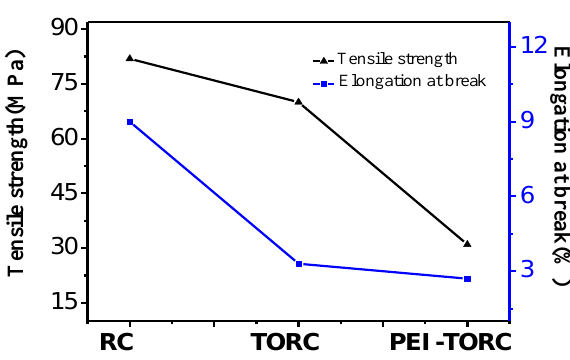
Figure 3. Tensile strength and elongation at break of RC, TORC and PEI-TORC membranes.